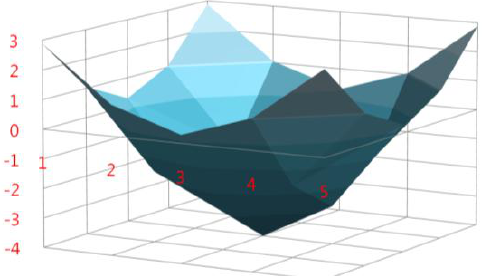
Figure 4. Visualization of modified 5 × 5 pixel Gaussian high-pass filter ( a = 10.9, b = — 4).